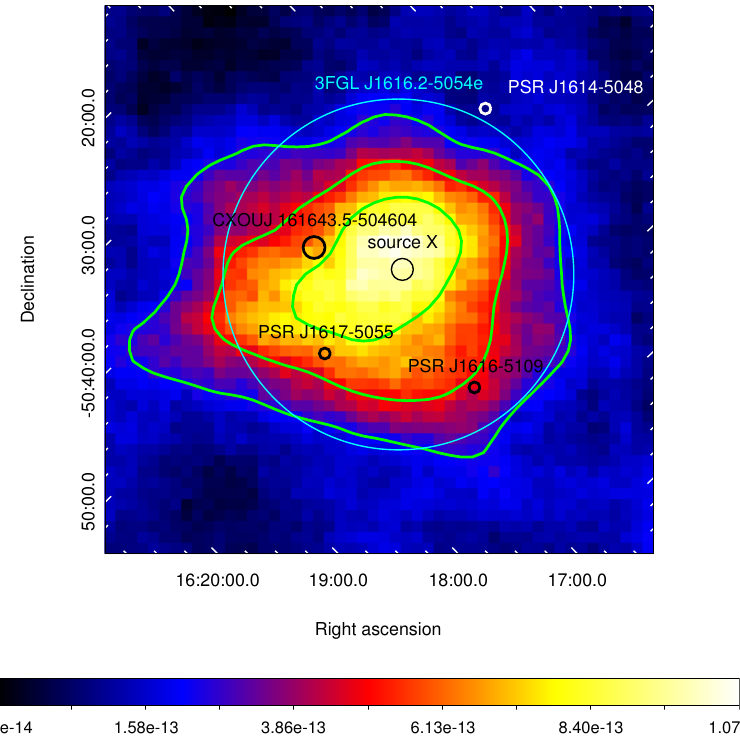
Figure 1. The significance contours of HESS J1616-508 overlapped on the flux map, as measured by H.E.S.S. [76]. The positions of the pulsars, the Fermi 3FGL source, and the interesting Chandra sources are